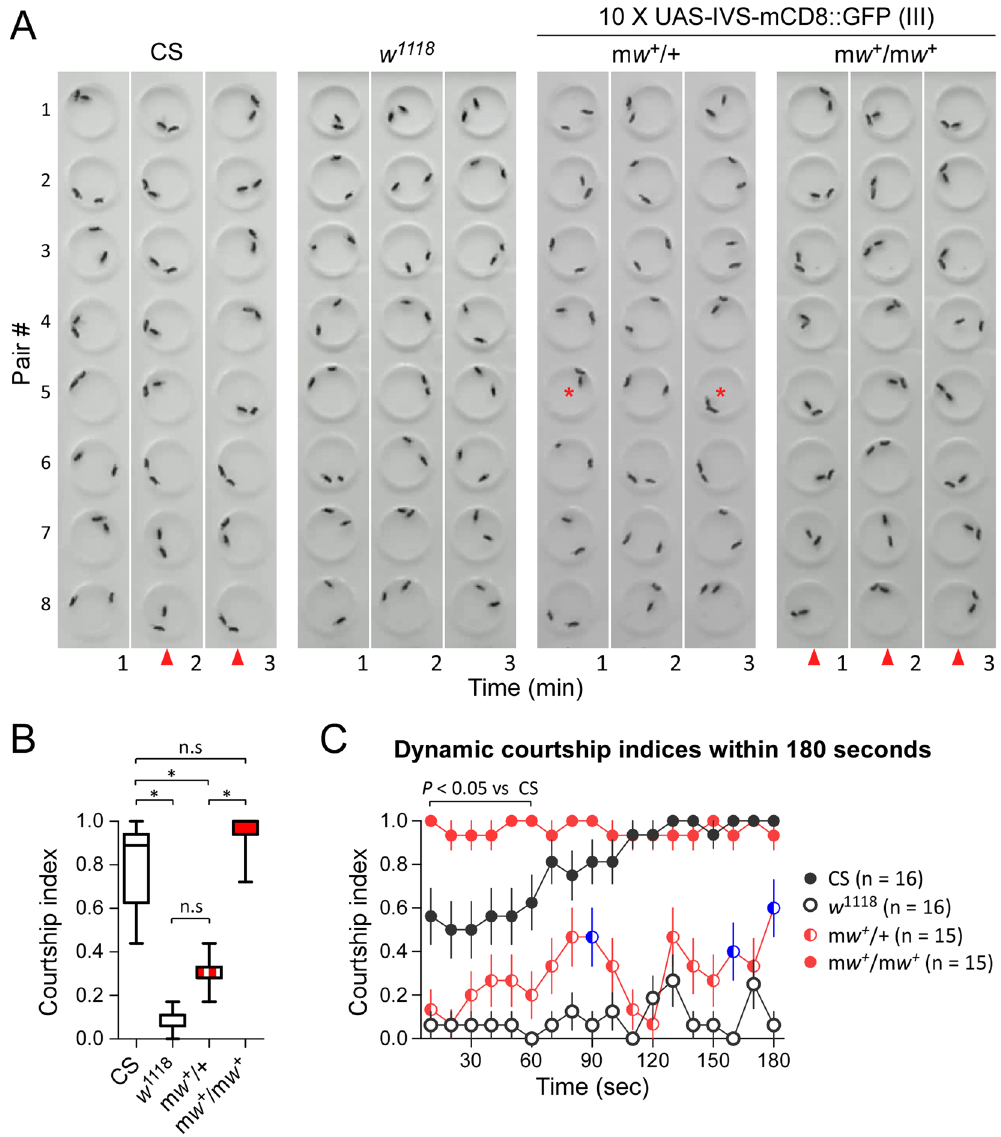
Figure 5. m w + rescued the reduced courtship in w 1118 flies. ( A ) Courtship activities before copulation in CS, w 1118 and m w + flies. Shown are the video-frames sampled once per minute during the first three minutes. Consistent courting between pairs at a time point in all or most pairs (red triangle), and sporadic courting seen in individual arenas (red star) are indicated. There are eight pairs for each genotype. Each pair contains a naive male and a virgin female. ( B ) Courtship indices within three minutes in tested flies. * P < 0.05 (one-way ANOVA); n.s., non-significance. ( C ) Dynamic courtship indices within the first 180 seconds in four genotypes. Courtship indices were repeatedly evaluated once every 10 seconds. P value is from two-way ANOVA. Sample sizes are